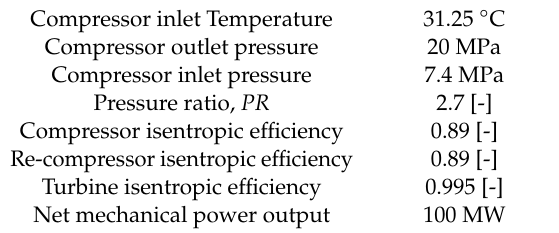
Table A4. Basic design and operating parameters used for the s-CO 2 Brayton cycles